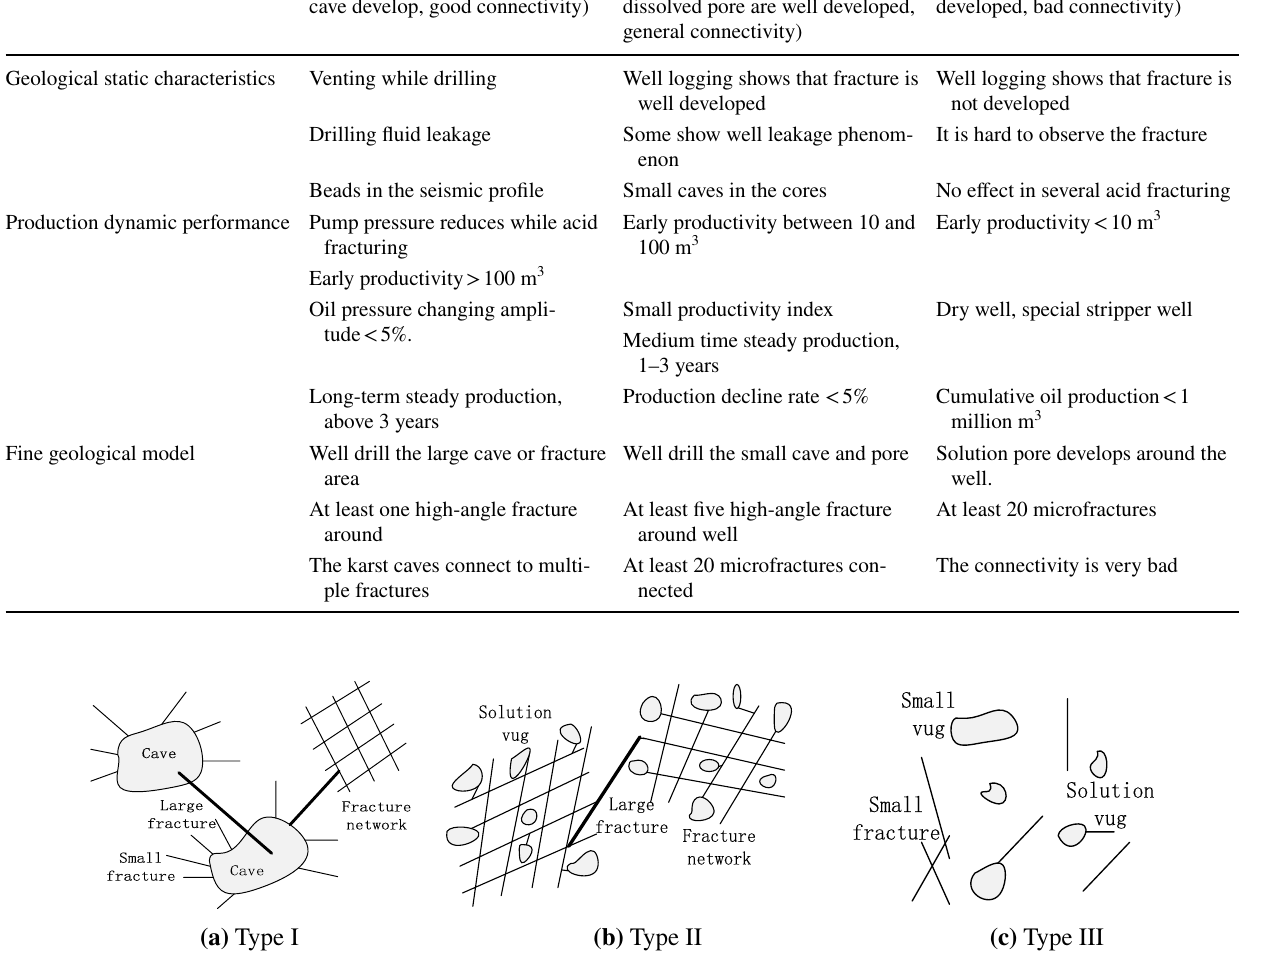
Table 1 Production well classification standard Well type/Distinguish basis